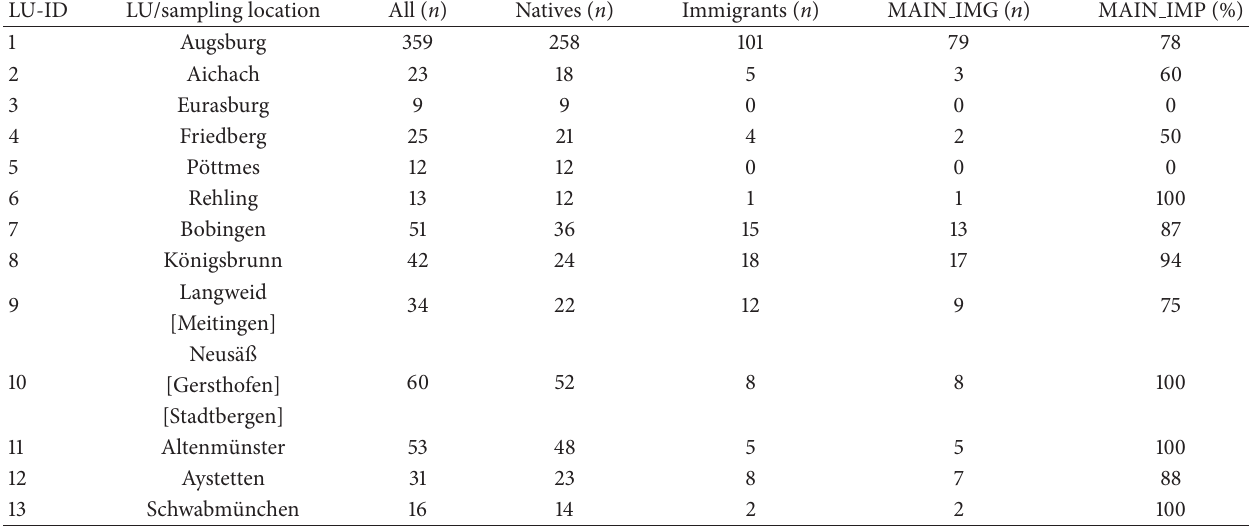
Table 1: Description of LUs and sampling locations, total count of samples, natives, immigrants, MAIN IMG (subset of German citizens born in either Czech Republic, Romania, Poland, or Ukraine), and values of MAIN IMP (percentage of individuals out of the total count of immigrants per land unit corresponding to the major immigrant group). Sampling locations with a low number of samples, which were aggregated to a contiguous sampled unit, are indicated in square